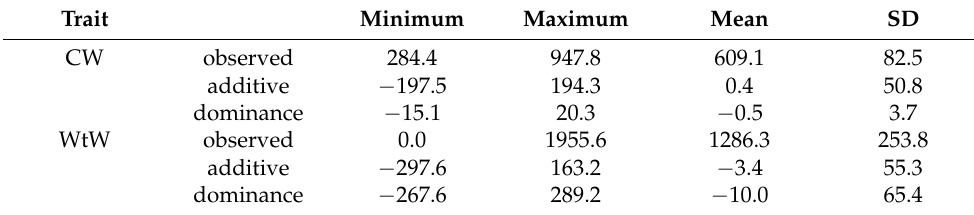
Table 2. Summary of observed 8-year-old cow weight (CW; kg) and cumulative weight weaned (WtW; kg), and predicted genomic additive and dominance